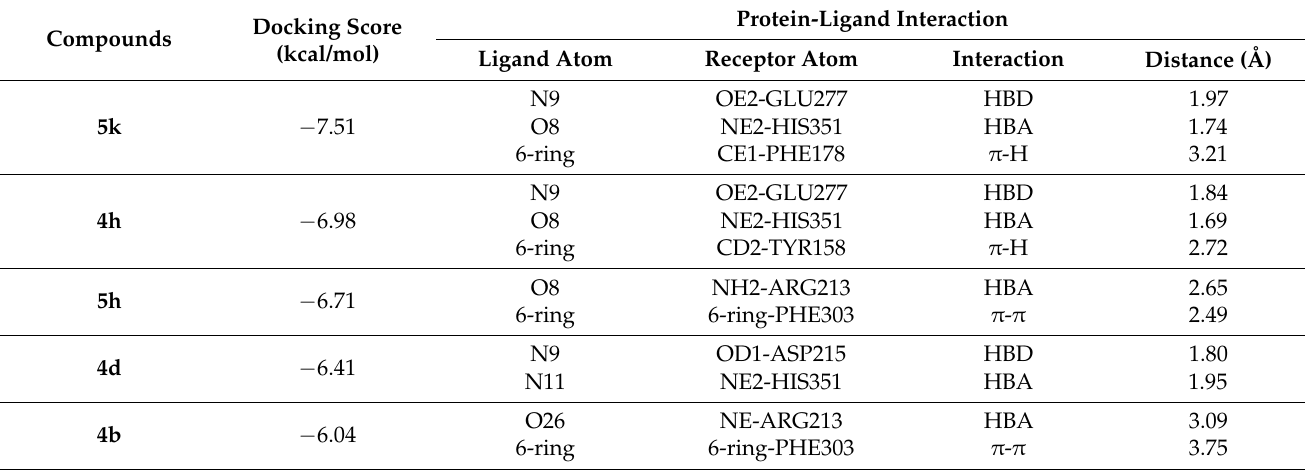
Table 2. Molecular Docking results of the Active α -glucosidase